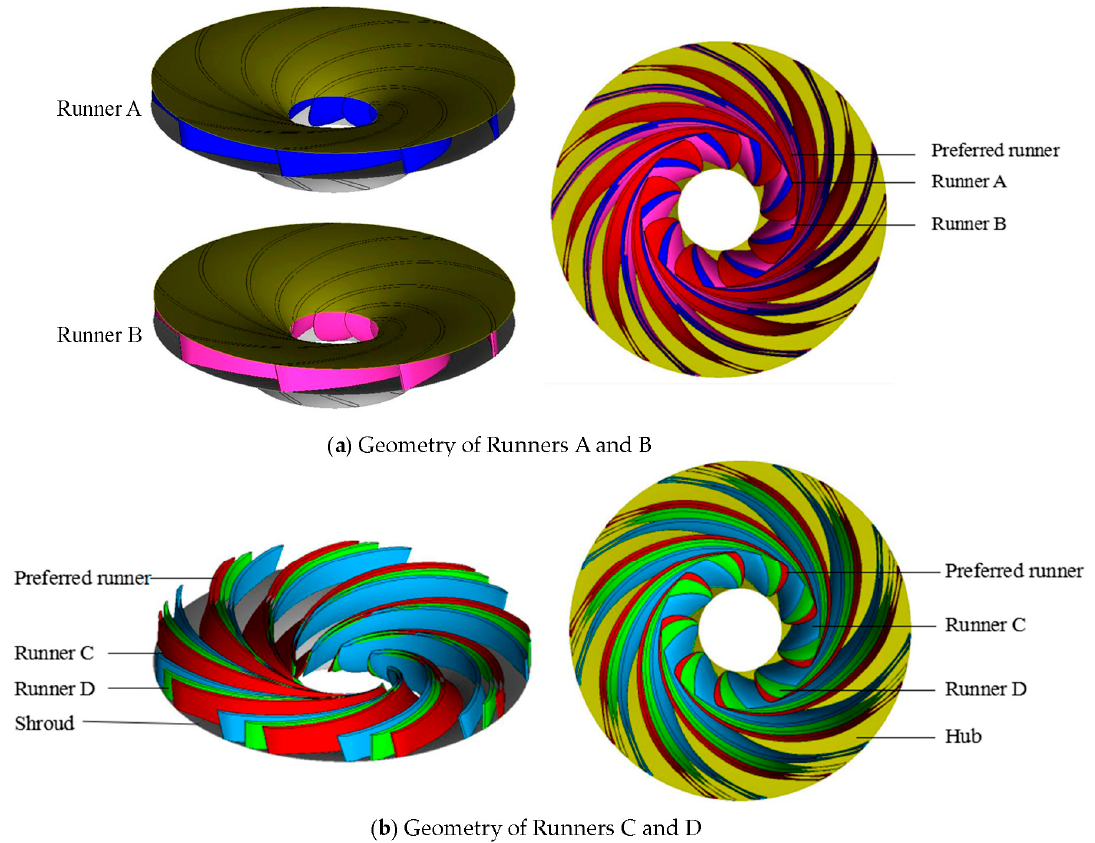
Figure 10. Blade configuration comparisons.